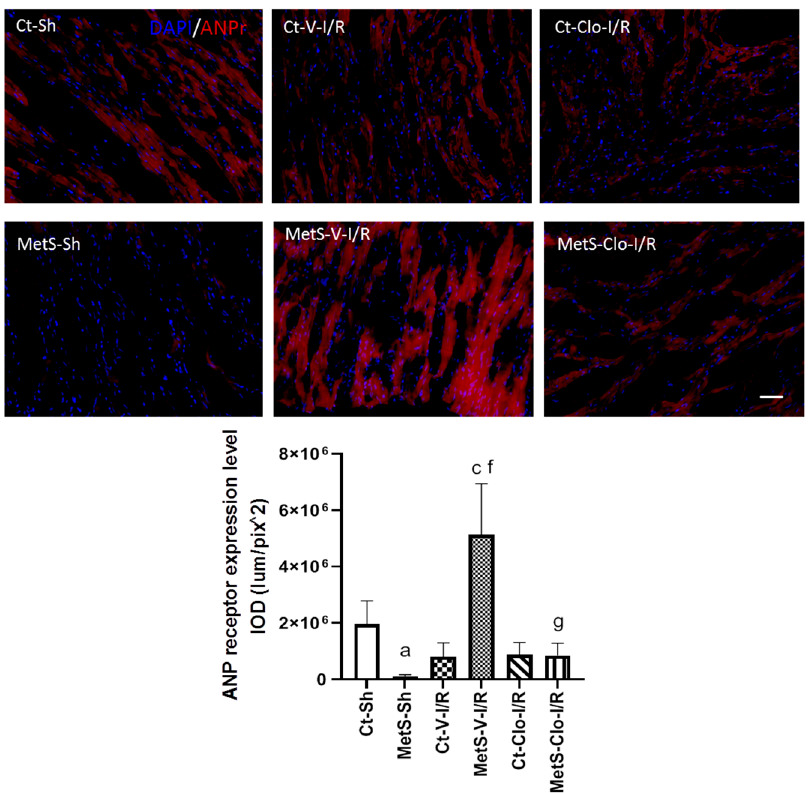
Figure 5. Effect of clofibrate treatment in the atrial natriuretic peptide receptor (ANPr) expression in left ventricles from MetS rats under ischemia/reperfusion conditions. Immunodetection of ANPr is shown in red and the nuclei are marked with DAPI. The graph shows the receptor expression levels. Data represent mean ± SEM. a p < 0.0001 vs. Ct-Sh; c p < 0.0001 vs. Ct-V-I/R; f p < 0.0001 vs. MetS-Sh; g p < 0.0001 vs. MetS-V-I/R. At least 4 fields of each animal (3 rats per group) were quantified, with a total of at least 12–24 determinations. Abbreviations: Ct = control; MetS = metabolic syndrome; Sh = sham-operated rats; V = vehicle; Clo = clofibrate; Bar = 100 μ m; IOD = integrated optical density, corresponding to ANPr expression level.